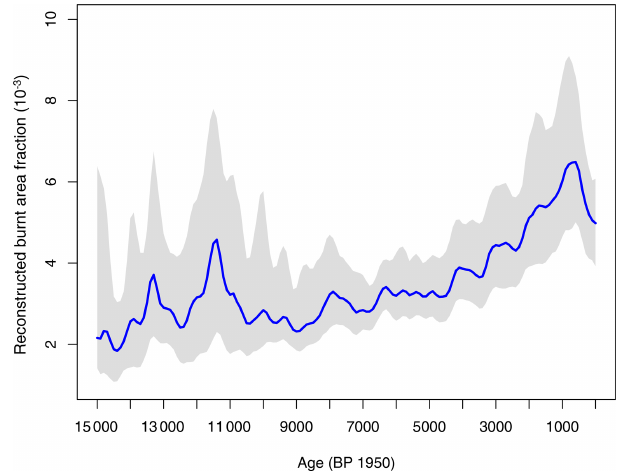
Figure 6. Composite curve of reconstructed burnt area using fxTWA-PLS, using the locfit() function with a half-width of 300 and 1000 bootstrap samples. The locally estimated scatterplot smooth- ing is shown in blue. The upper and lower 95th percentile confi- dence intervals are shown in